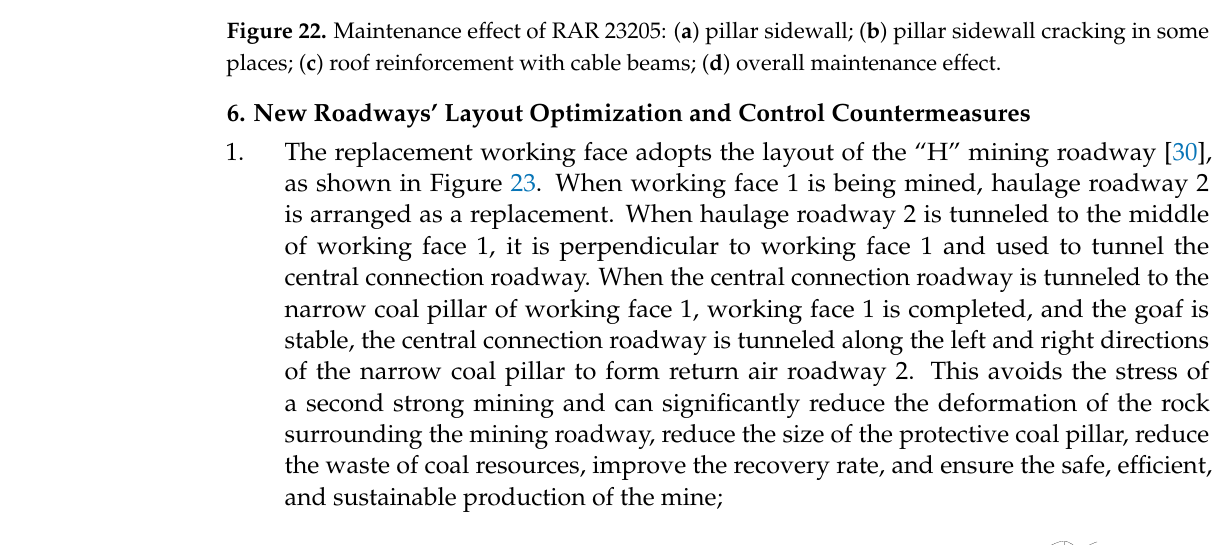
arrow represents the tunneling direction. The numbers 1 and 2 represent the first and second working